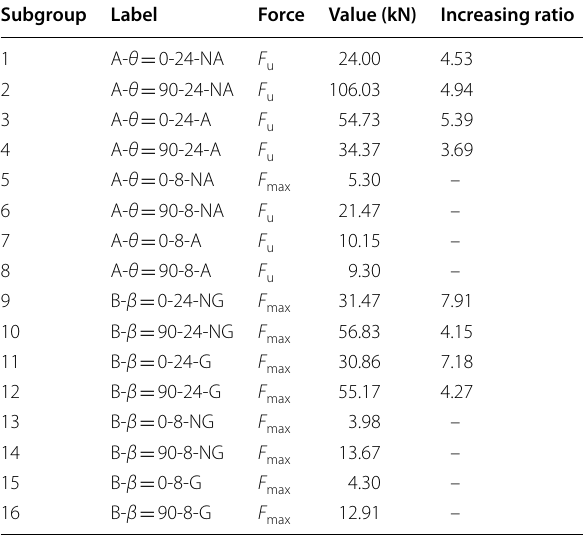
Table 3 F or F obtained from the average force– u max displacement